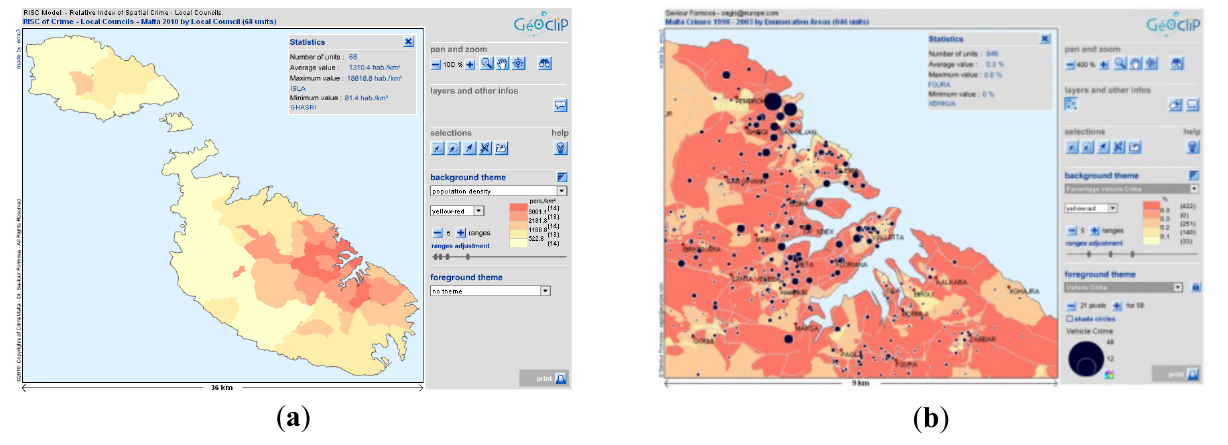
Figure 4. Malta Crime Web-GIS: www.crimemalta.com ( a ) Choropleth ( b ) RISC map: choropleth and